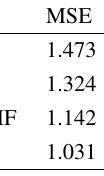
Table 3 Experimental